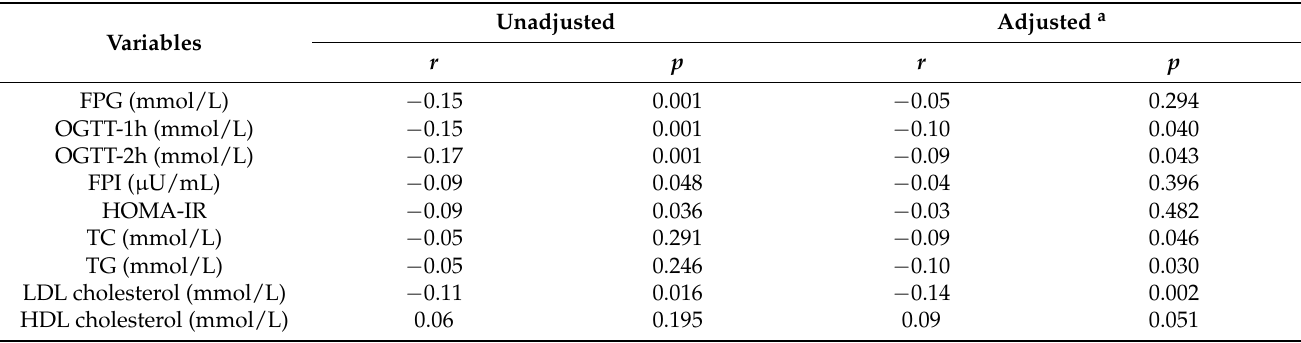
Table 3. Correlation coefficients between V and metabolic